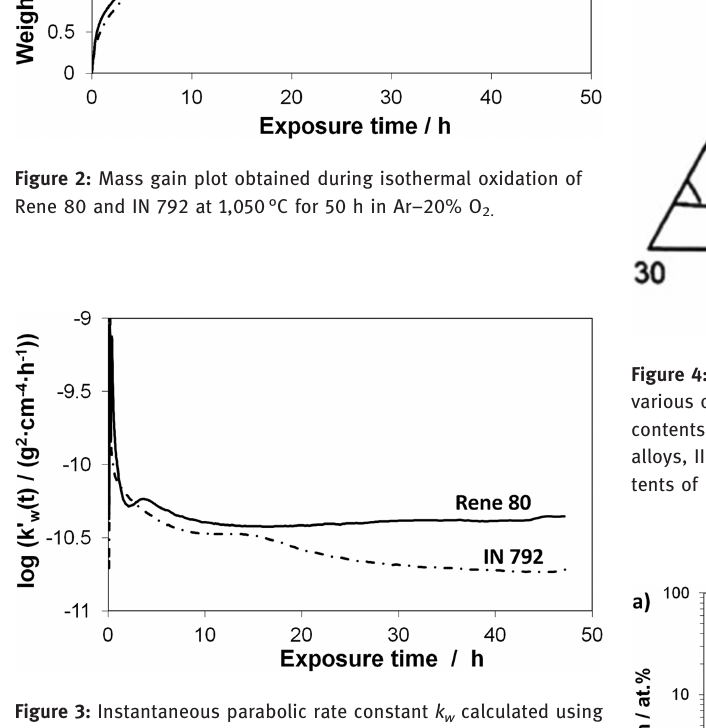
Figure 3: Instantaneous parabolic rate constant k w calculated using data according to the procedure described in [13, 14].